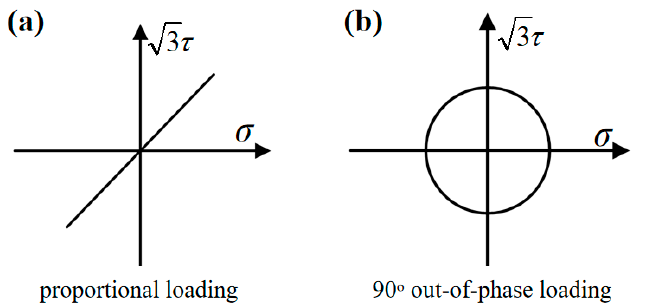
Figure 3. The load path of tension–torsion corrosion fatigue (stress control). ( a ) proportional loading and ( b ) 90 ◦ out-of-phase loading.